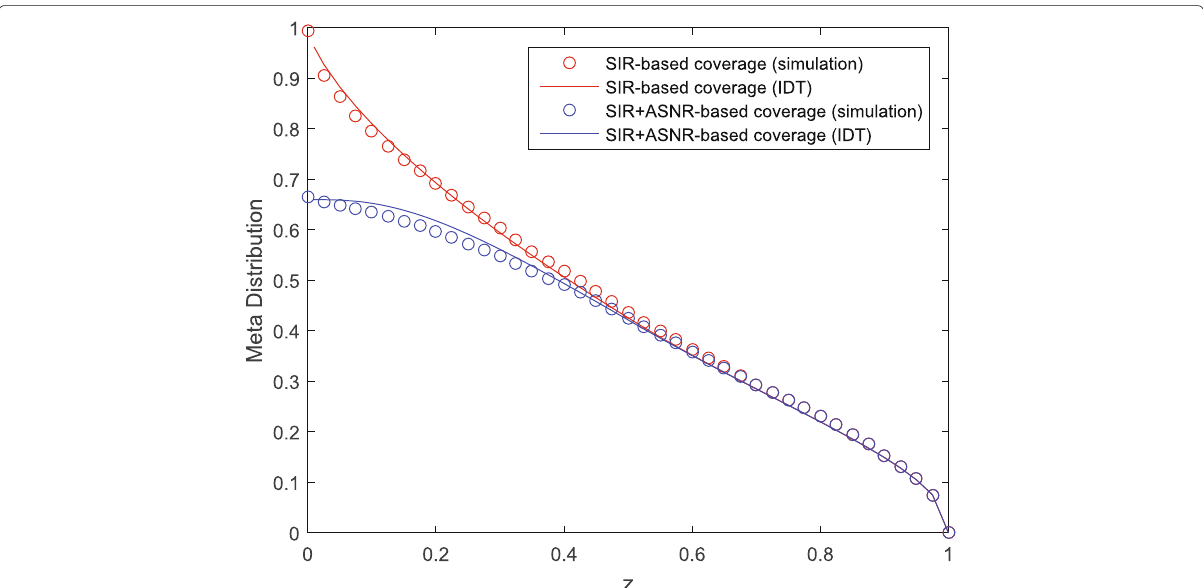
Fig. 3 Meta distribution: Comparison between the SIR-based and SIR + SNR-based definition of coverage (ASNR=SNR). Setup: Log-Gaussian Cox point process case. Solid lines: IDT framework. Markers: Monte Carlo simulations